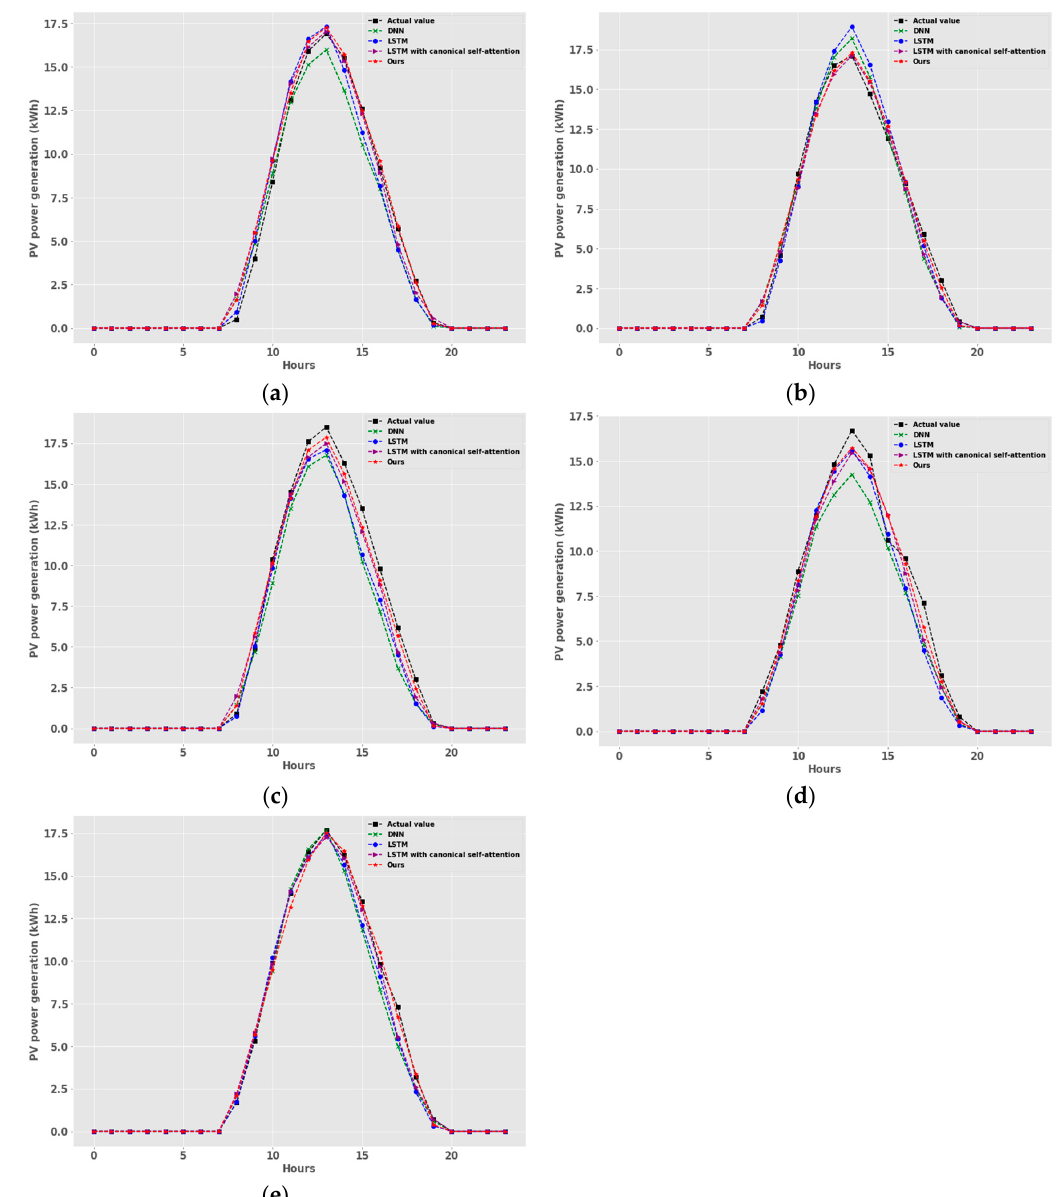
Figure 8. Forecasting results: ( a ) forecasting result on 8 March 2020; ( b ) forecasting result on 12 March